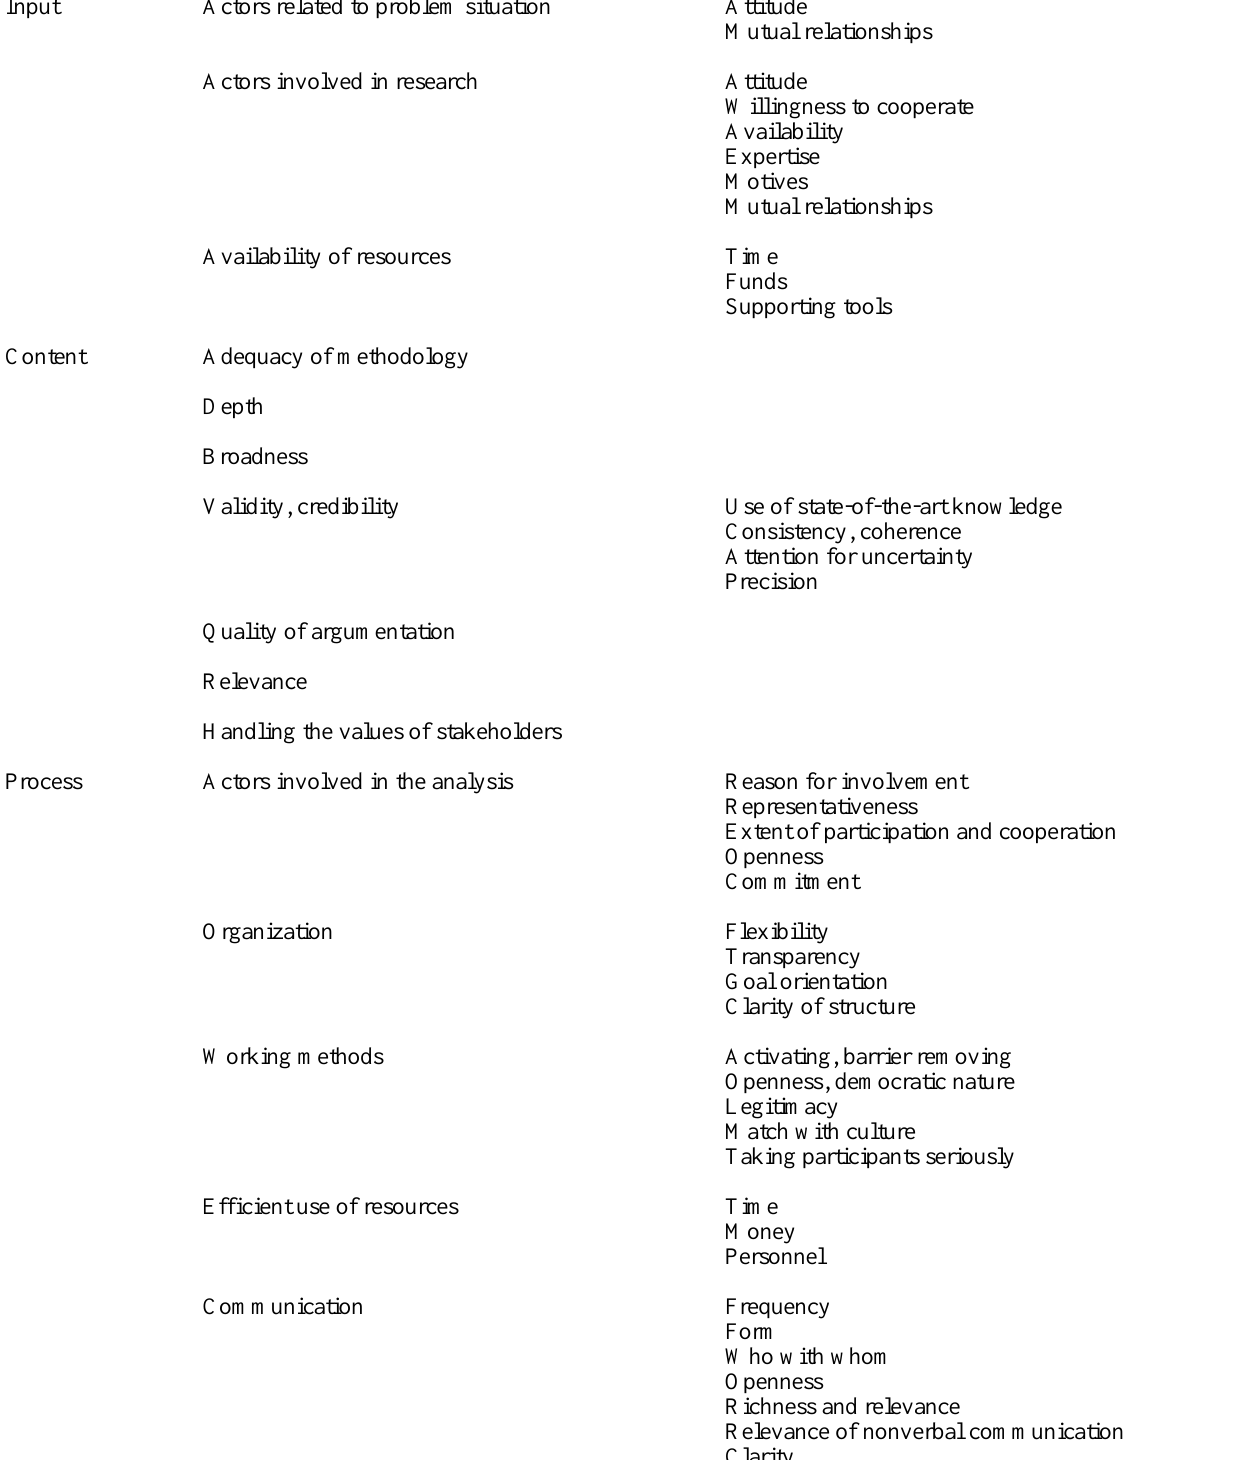
Table 1. Criteria used in the evaluation of the Joint Incomati Basin Study.